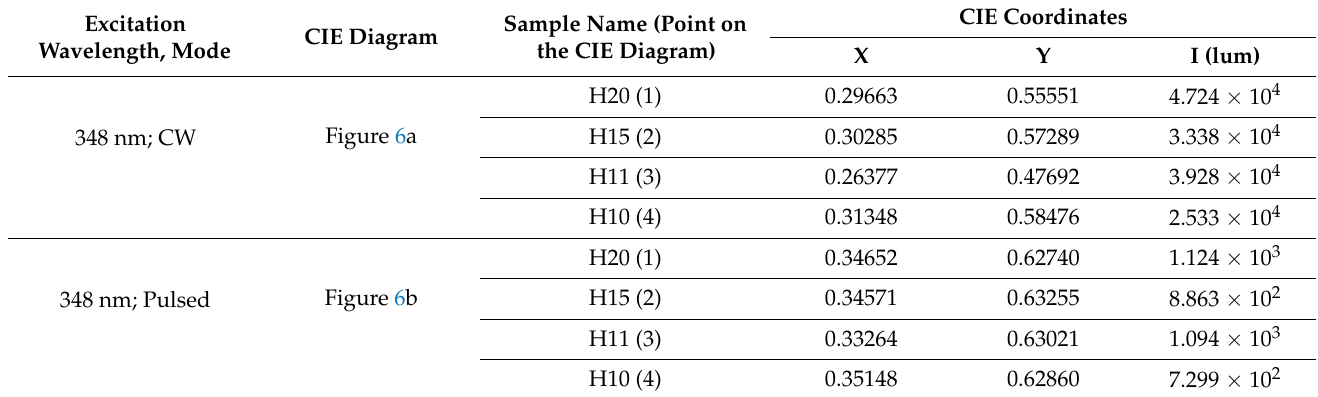
Figure 8. CIE 1931 chromaticity diagram of the Ho-SiAlON ceramics samples (a) upon 348 nm CW excitation (b) upon 348 nm pulsed excitation. Corresponding CIE coordinates are listed in Table 3. The emission modulation under CW and pulsed excitations result in different emission colors. Table 3. CIE coordinates of Ho-SiAlON ceramic samples under 348 CW and pulsed excitations.